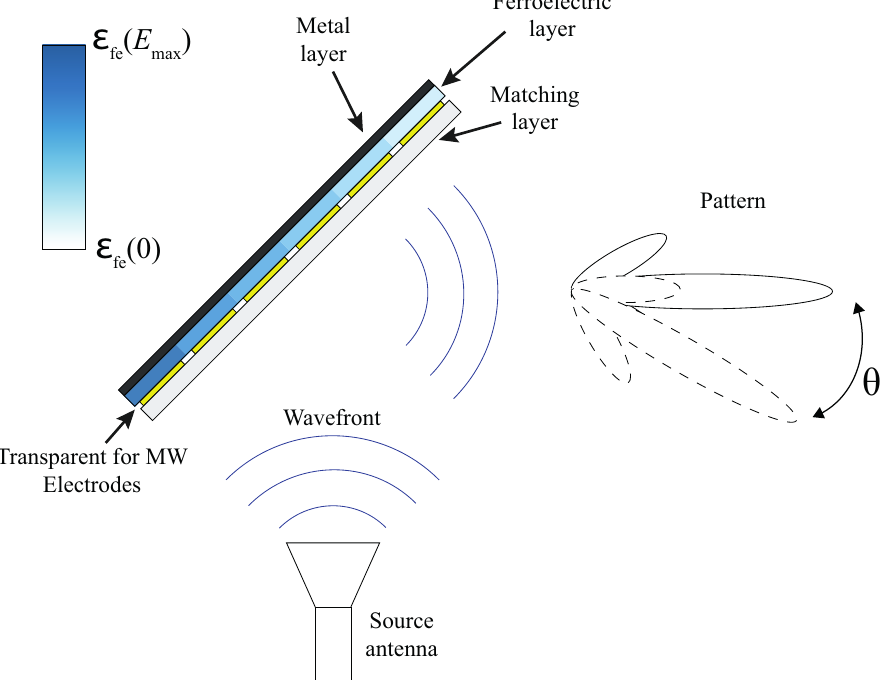
Figure 1. Schematic of the proposed ferroelectric